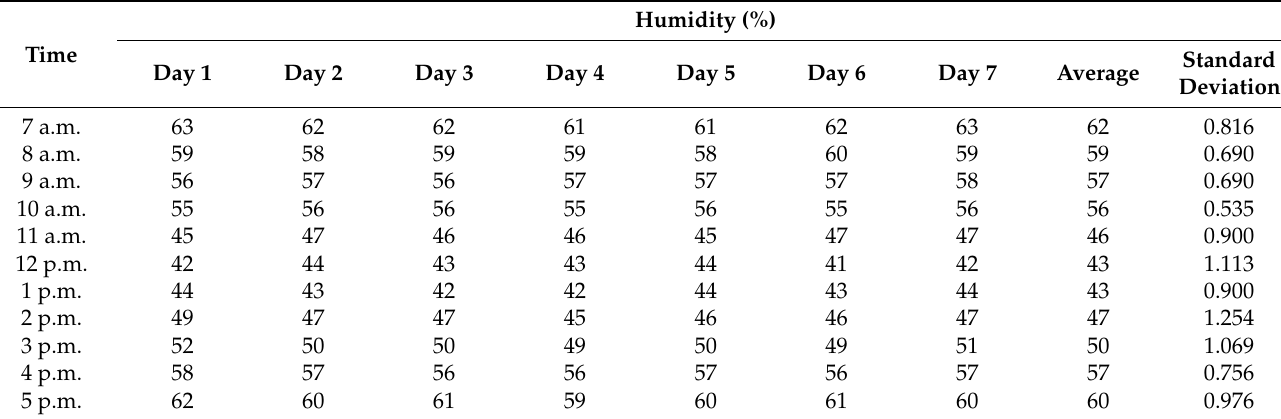
Table 2. Humidity in the greenhouse without the misting